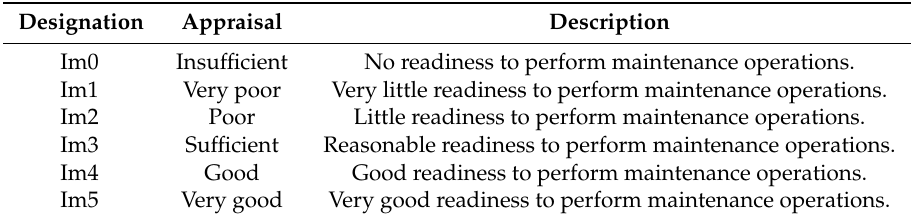
Table 4. Evaluation of the maintainability index (MI).